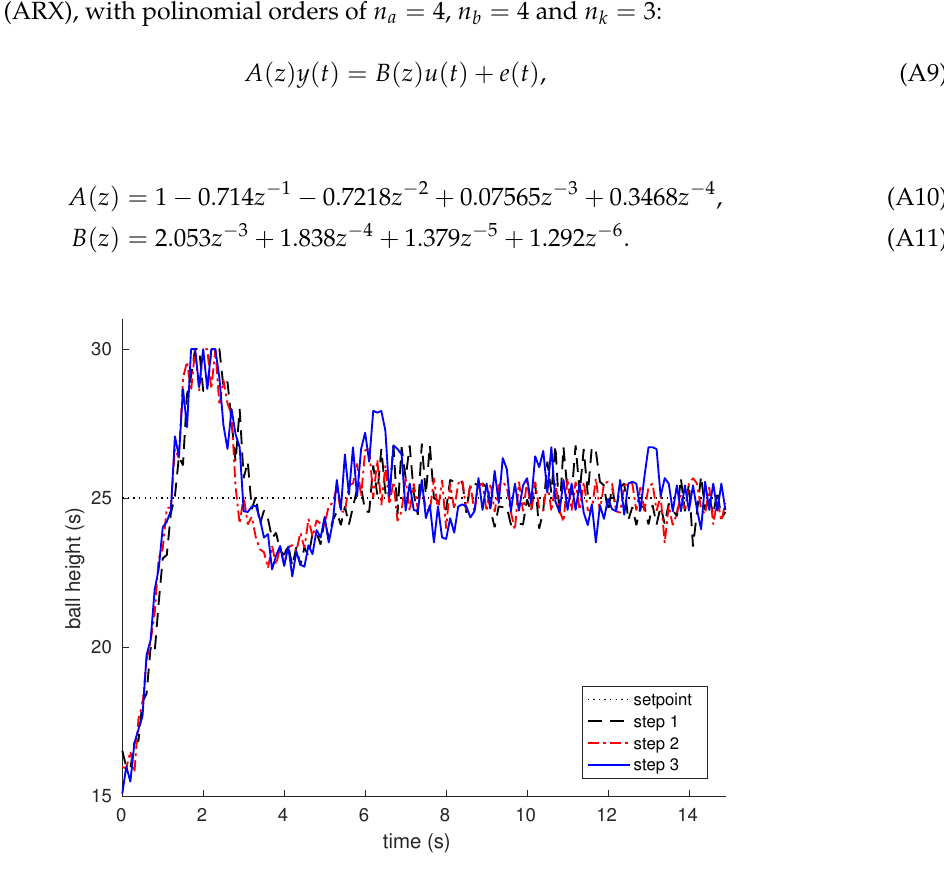
Figure A2. Response to a step input of amplitud 10 cm at the setpoint.